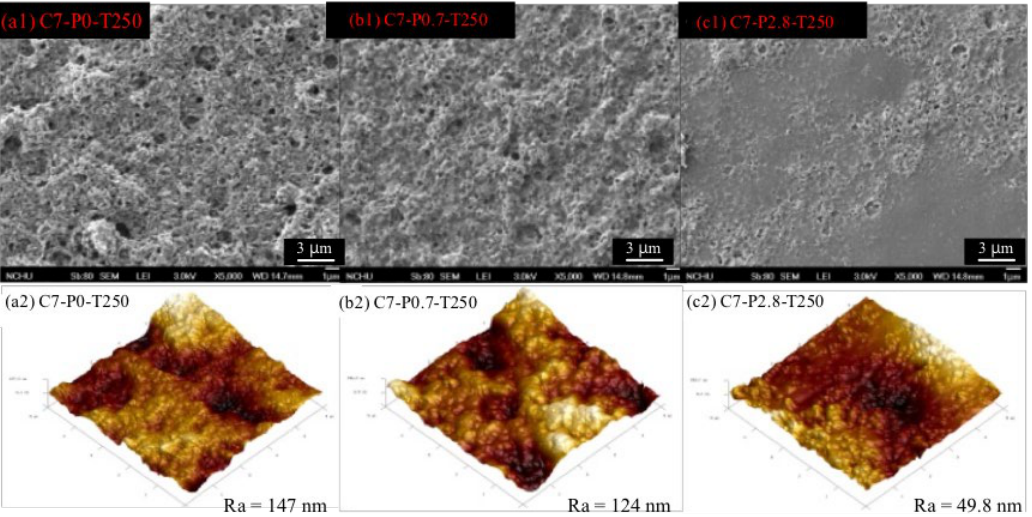
Figure 9. SEM images ( 1 ) of rubber-derived TR membranes as a function of polyphenylene oxide (PPO) additive content and corresponding atomic force microscopy (AFM) images ( 2 ). ( a : C7-P0-T250; b : C7-P0.7-T250; c : C7-P2.8-T250).